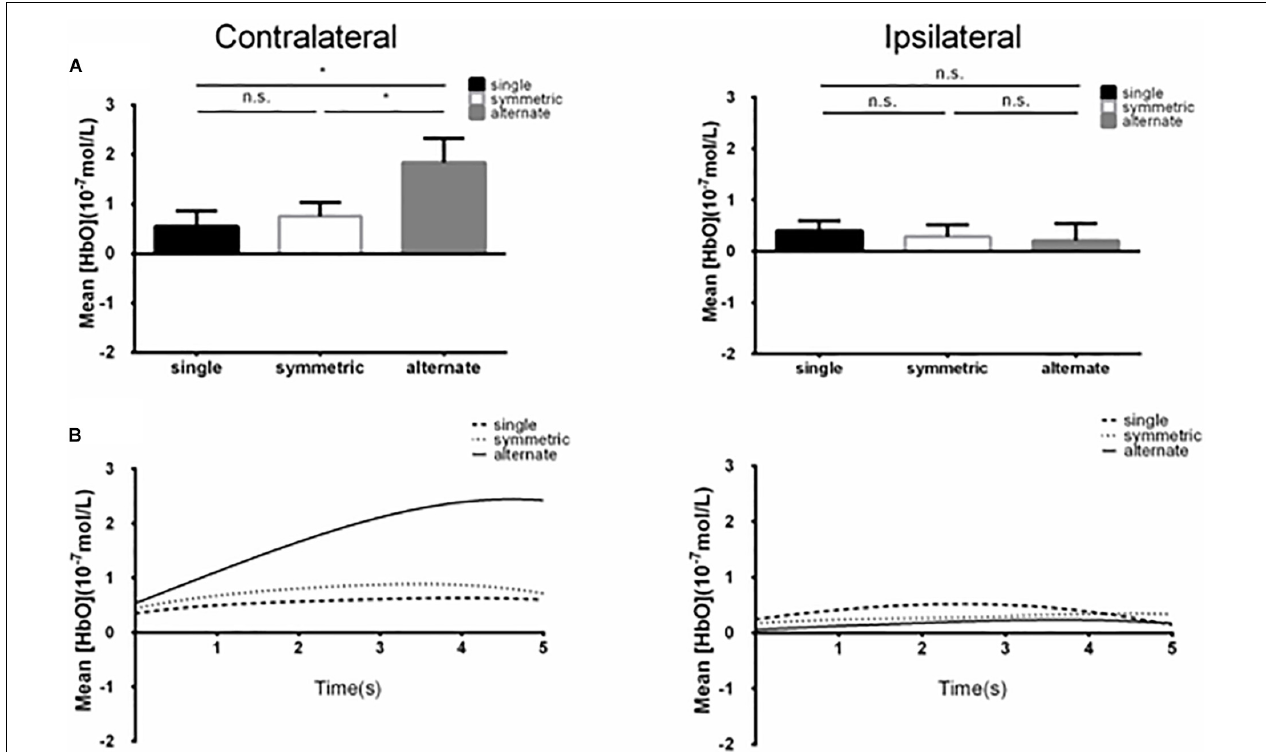
FIGURE 2 | (A) Summary of mean [HbO] for the side of the brain contralateral (left) and ipsilateral (right) to movement averaged across ROI-2 (channels 13 and 14) corresponding subjects, and times. Left, the mean [HbO] values for the alternate mode were significantly larger than those obtained for symmetric and single modes; mean [HbO] values did not differ significantly between the symmetric and single modes. ∗ p < 0.05; n.s., p > 0.10. Error bar: standard error (B) [HbO] time course contralateral (left) and ipsilateral (right) to movement. Mean [HbO] values across two channels (ROI-2, channels 13 and 14) and corresponding subjects are